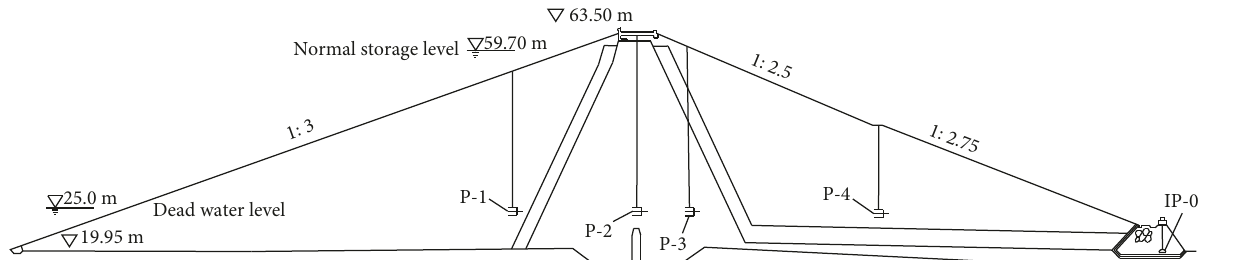
Figure 1: Dam section and layout of piezometers and inclinometer pipes.